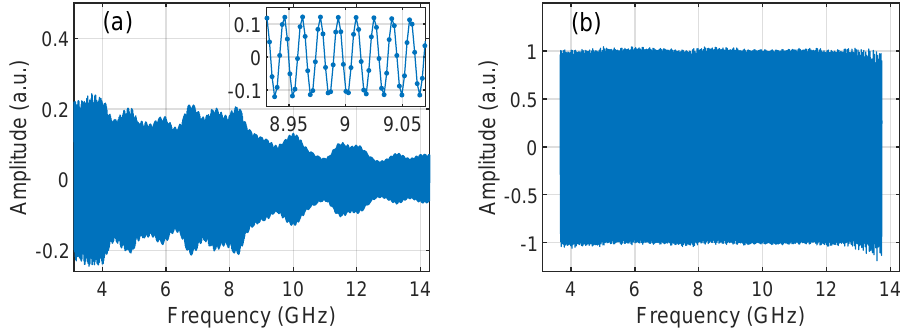
Figure 5. ( a ) Spectral interferogram H n [ k ] used for normalization and calibration, where the FUT is the reflection in a flat fiber end located 1 m after the circulator. Inset: Zoom over the 9-GHz region. Points are H n [ k ] samples; ( b ) Normalized and calibrated interferogram H [ k ] , where the flat fiber end is situated 3 m after the calibration plane. Notice the constant level in a 10-GHz bandwidth and the trimming of H [ k ]